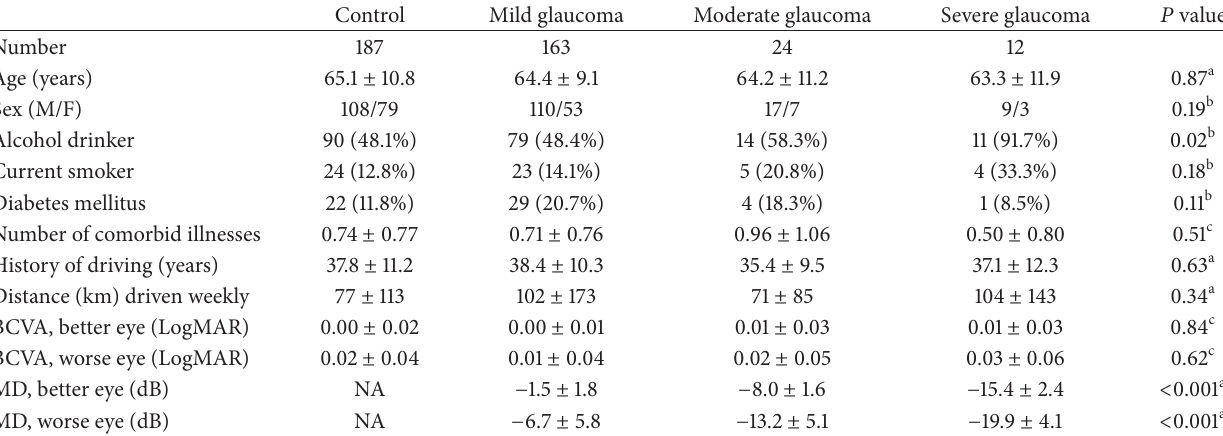
Table 2: Demographic characteristics, grouped by MD in the better eye.